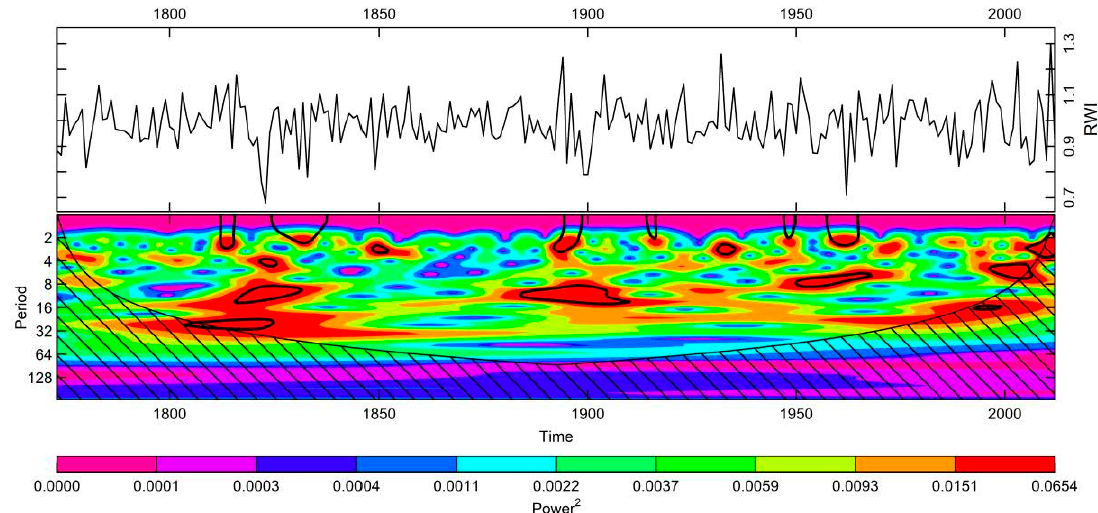
Figure 8. Wavelet power spectrum of A. pindrow tree ‐ ring index.